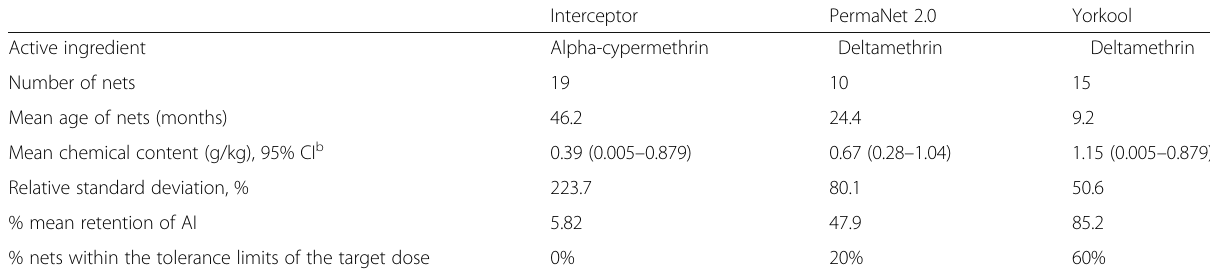
Table 3 Mean chemical content and retention of active ingredient (AI) by LLIN